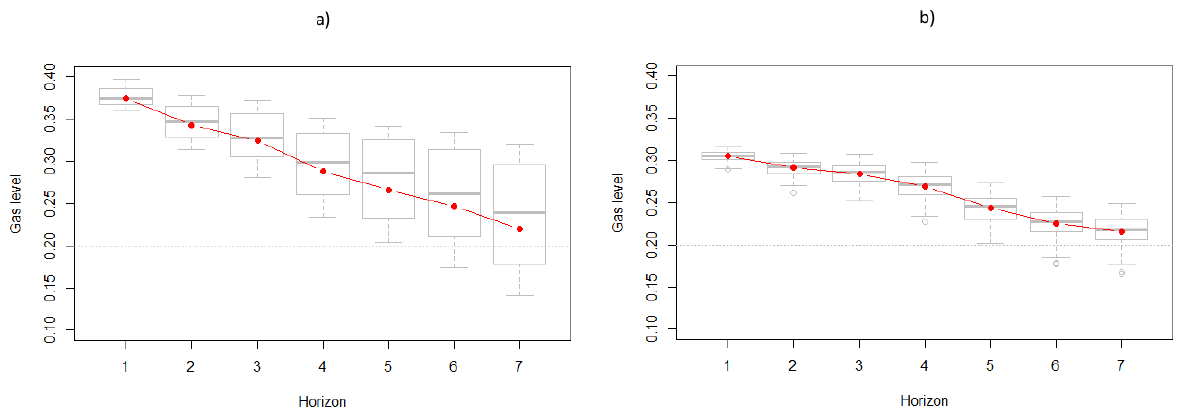
Figure 7. Error range visualized as a boxplot around the predicted gas level (dots) resulting in must go ( a ) and can go ( b ) recommendation for seven day prediction. Gas level is calculated as a percentage of the tank capacity, prediction horizon is presented in